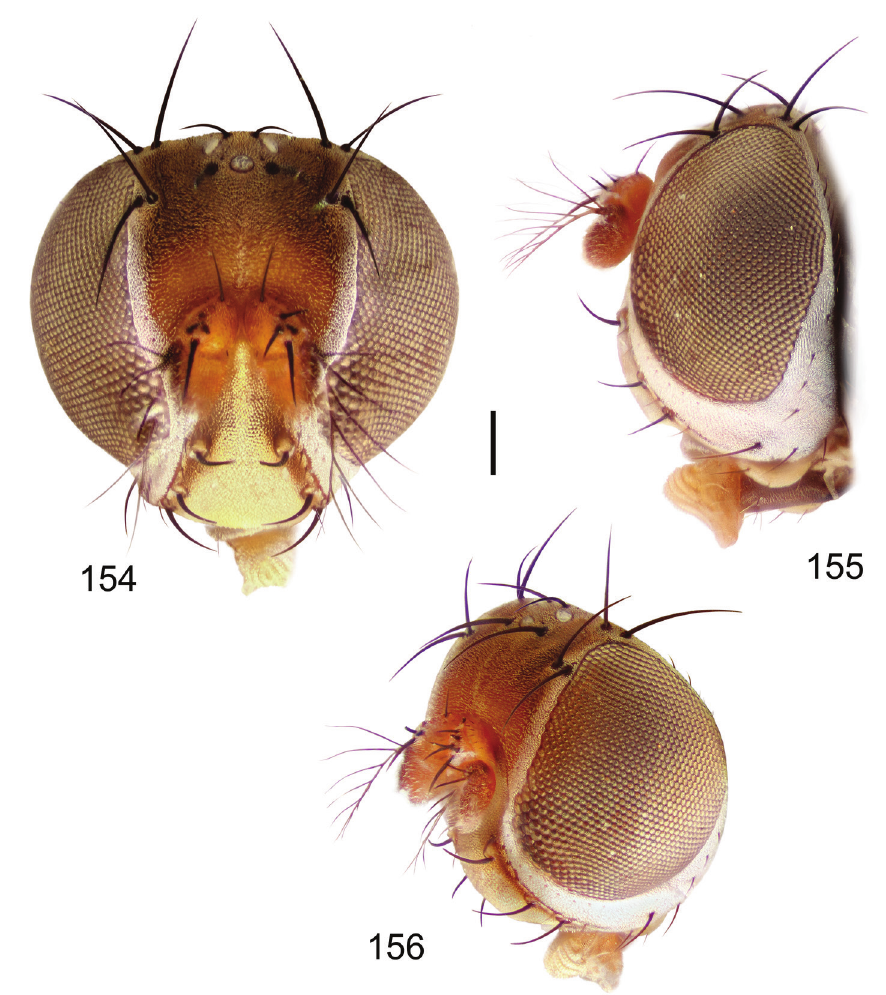
Figures 154–156. Hydrochasma capsum sp. n. (Puerto Rico. Maricao) 154 head, anterior view 155 same, lateral view 156 same, oblique view. Scale bar = 0.1